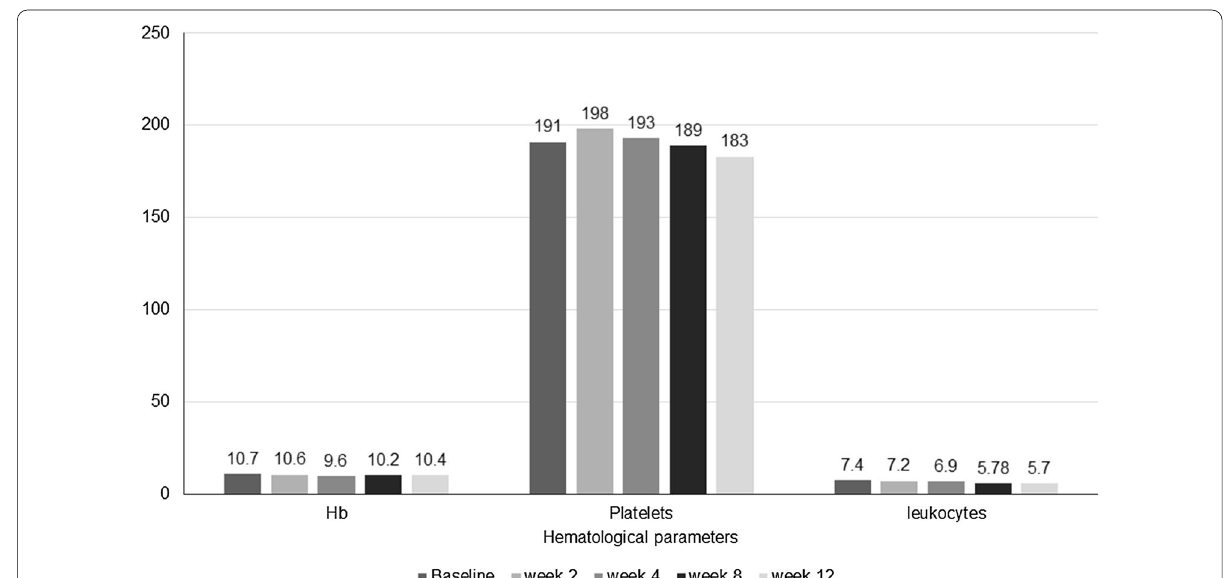
Fig. 6 Median haematological parameters after [ 177 Lu]Lu-DOTA-ZOL